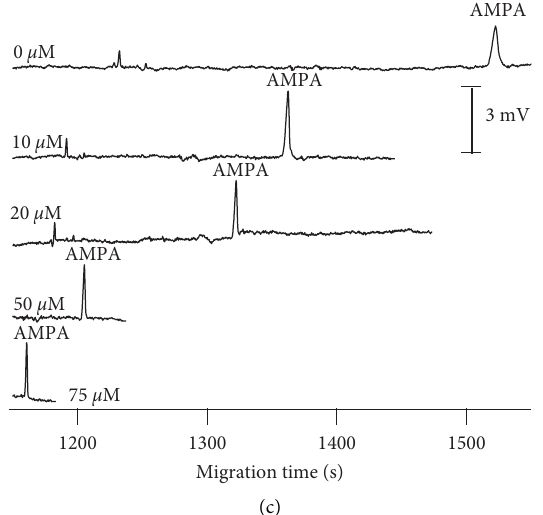
Figure 2: Electropherogram for the optimization of BGE compositions for determination of AMPA. CE conditions: voltage: 20kV from the detection side; uncoated fused silica capillary with ID � 50 µ m, Lt � 70cm, and Leff � 62cm.